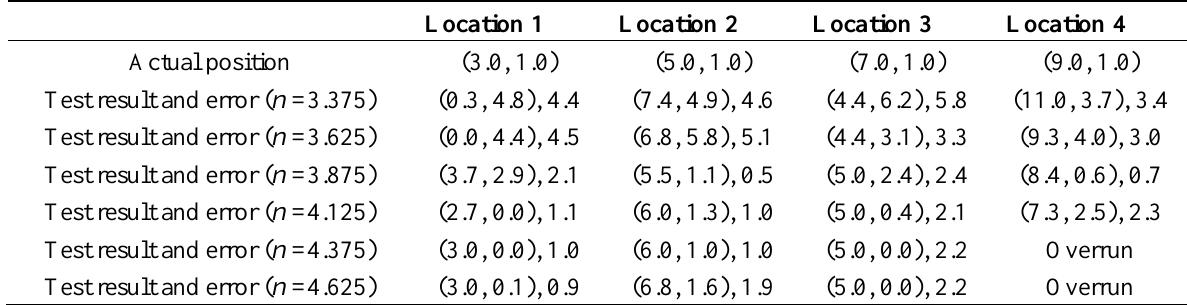
Table 7 . The experiment test results and error (meter), A =